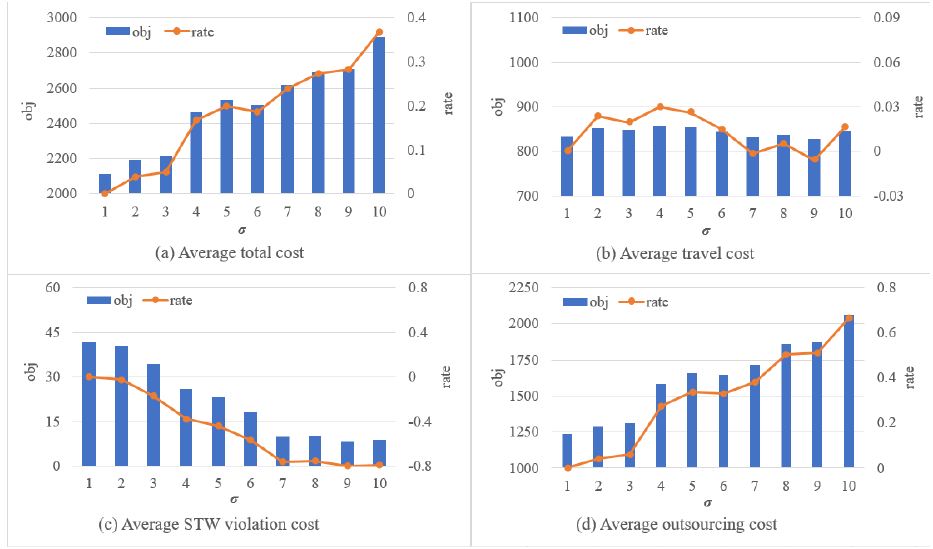
Figure 3. Comparison results with different σ